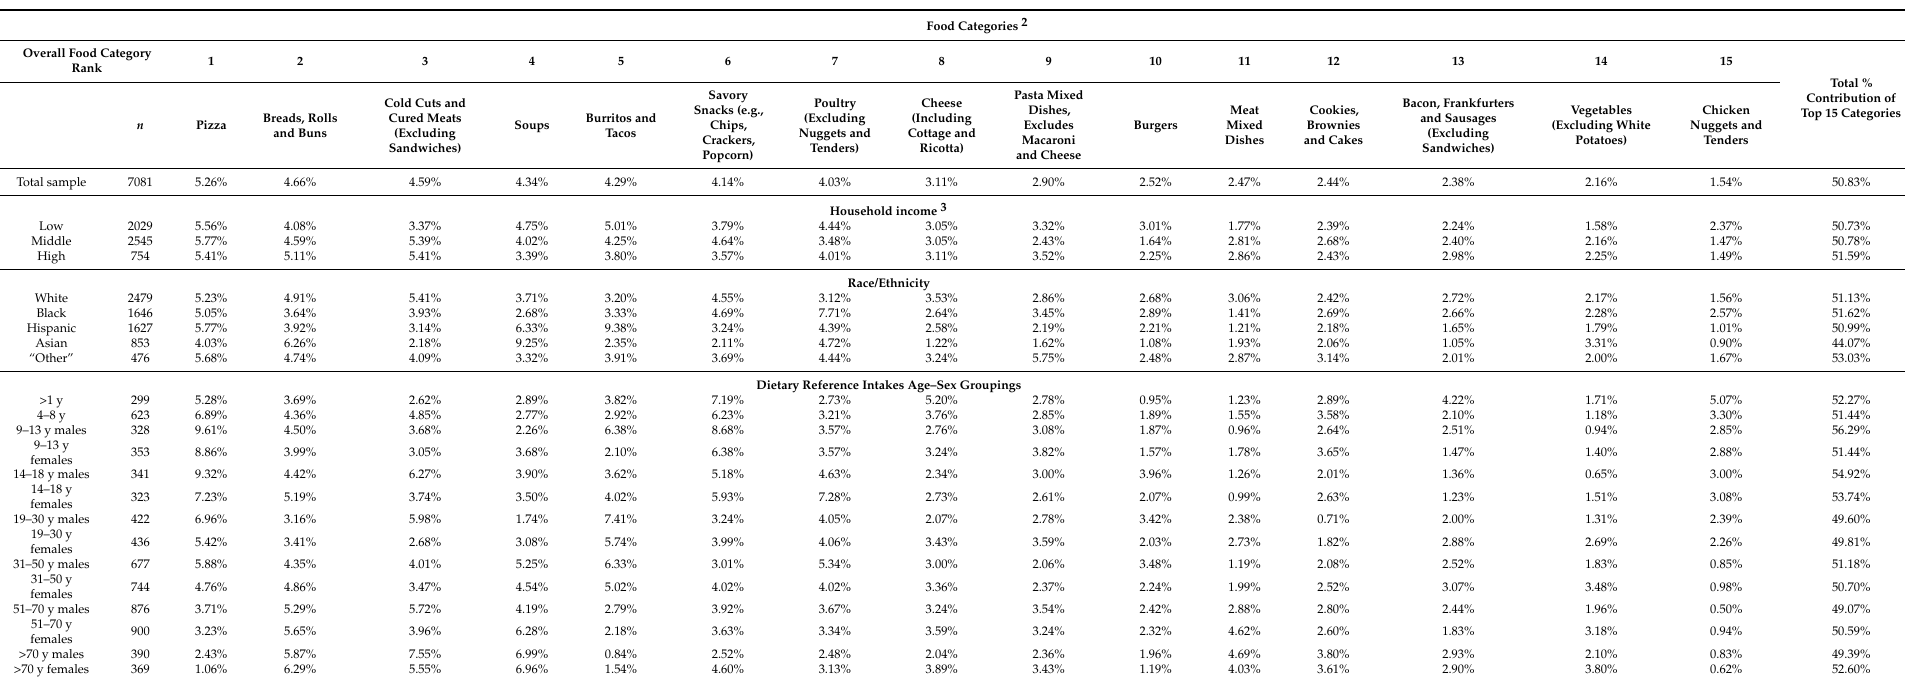
Table 1. Contribution to total daily sodium by food category (%), NHANES 2017–2018 1 for the total sample and by